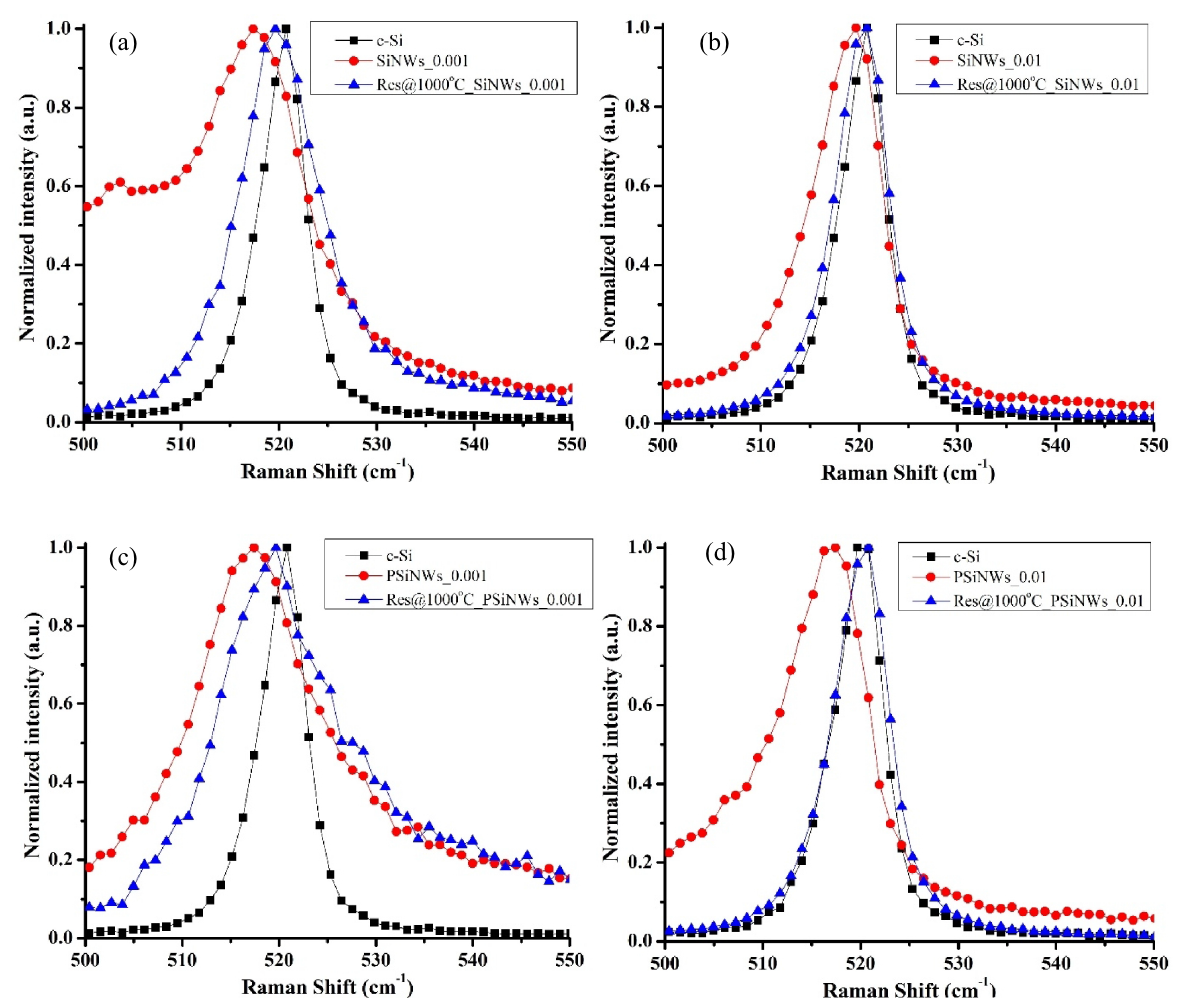
Figure 5. Raman spectra of pristine and sintered NWs (@1000 °C) for ( a ) SiNWs_0.001, ( b ) SiNWs_0.01, ( c ) PSiNWs_0.001, ( d )